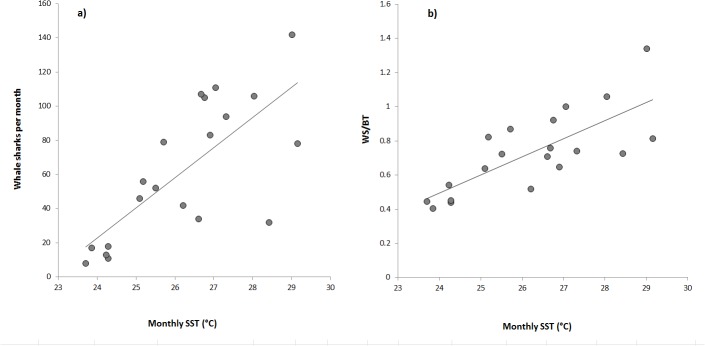
Relationships between whale sharks per month (WS), whale sharks per boat trip per month (WS/BT) and the monthly SST (°C).WS = 17.65SST – 400.69, R2 = 0.54, p = 0.0002 and WS/BT = 0.11SST – 2.05, R2 = 0.57, p = 0.0001.